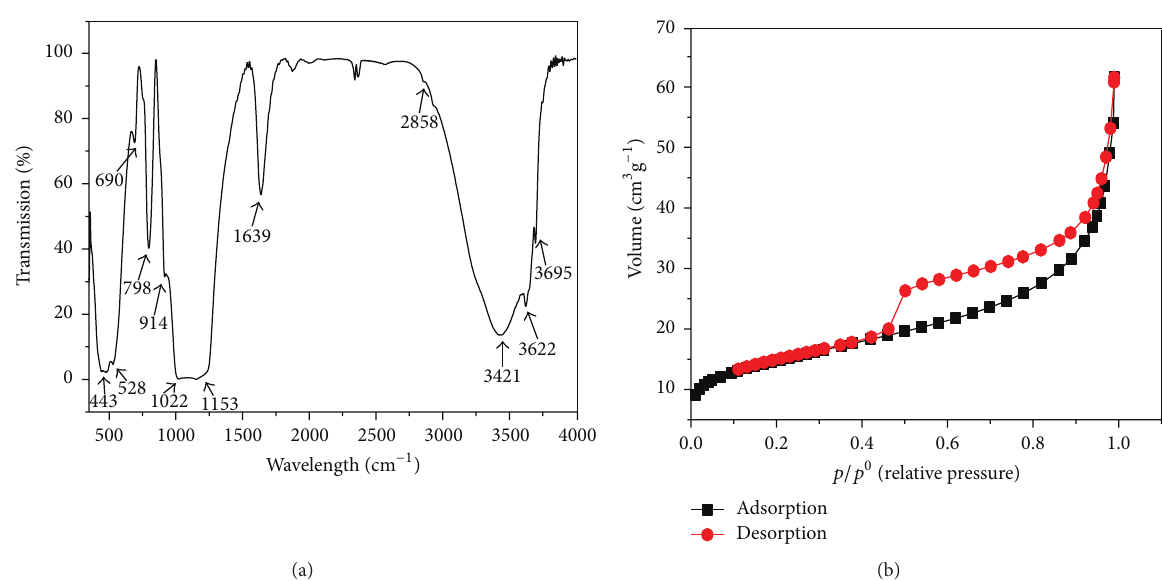
Figure 2: FTIR spectrum (a) and nitrogen adsorption/desorption isotherms (b) of